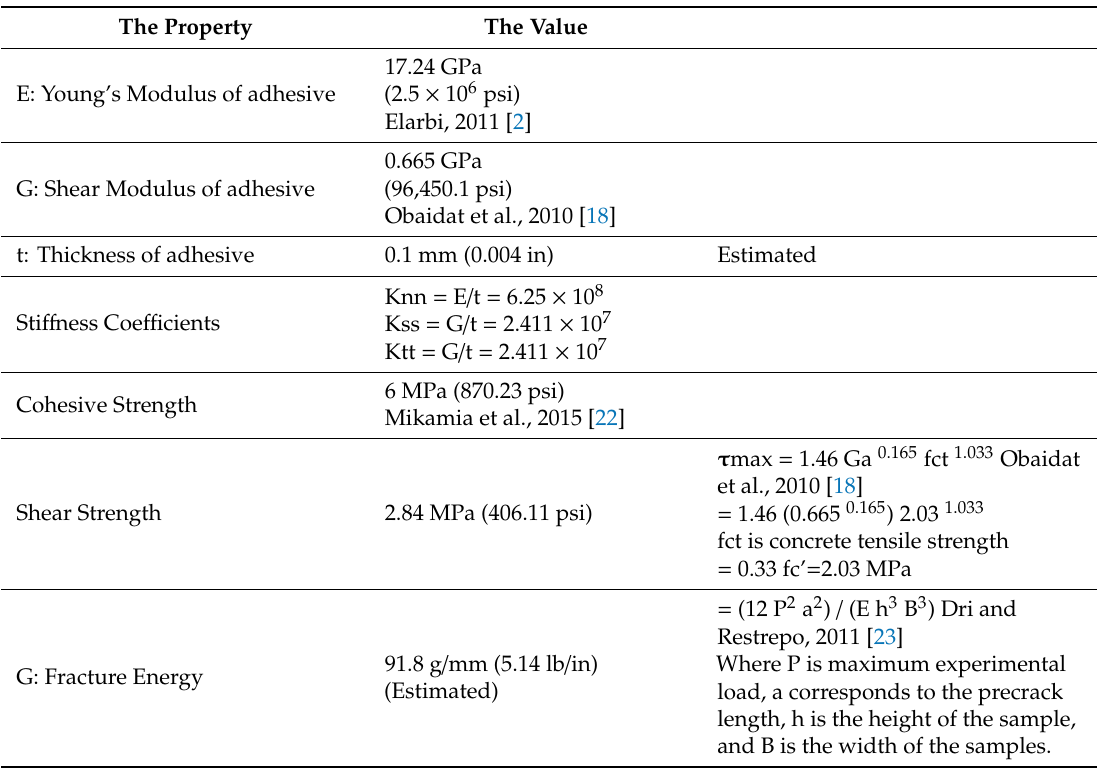
Table 3. Adhesive Properties.